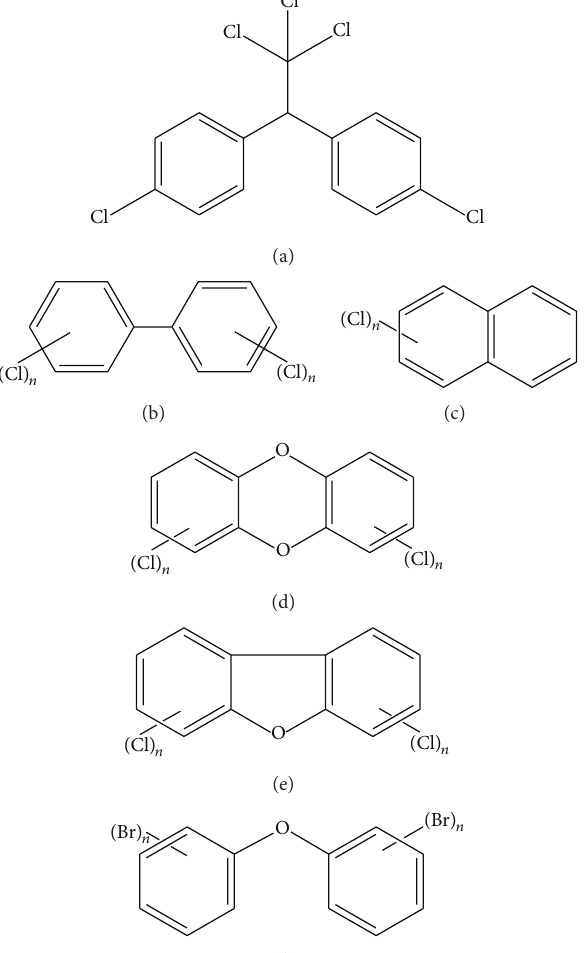
Figure 1: Generic structure of the (a) DDT, (b) PCBs, (c) PCNs, (d) PCDDs, (e) PCDFs, and (f)